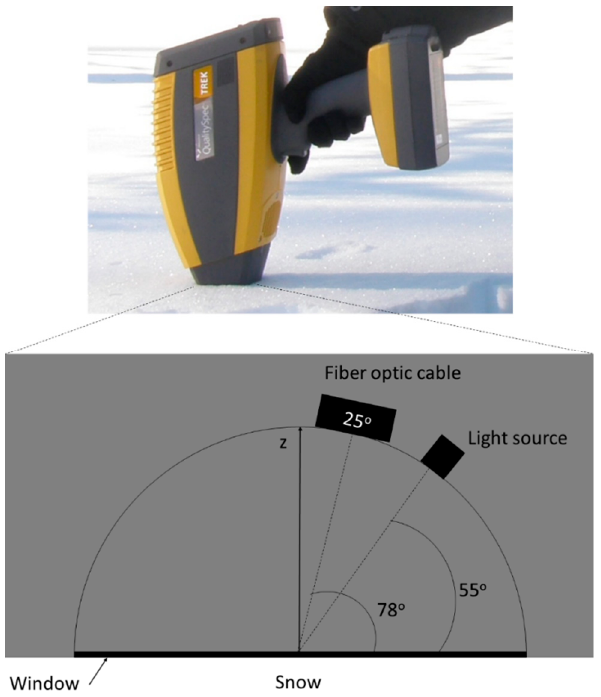
Figure 3. Illumination and viewing configuration. Fiber optic and light source have the same azimuth angle. Fiber optic cable has 25° field of view. Diameter of the window is approximately 1 cm.